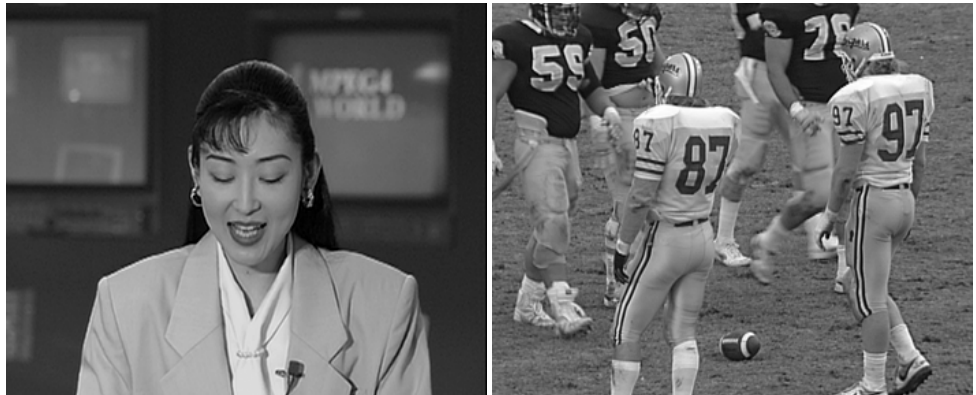
Figure 14. Left-hand side : “Akiyo” original frame. Right-hand side : “Football” original frame. Videos extracted from